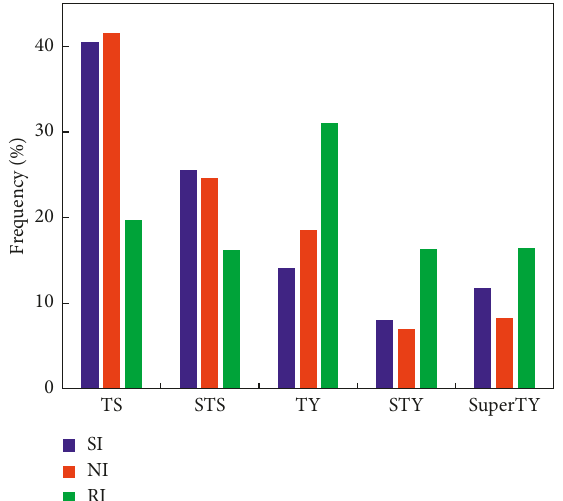
Figure 3: The frequency distribution of the initial intensity of the development in the three intensification categories (RI, NI, and SI) for the period 1995–2015. The definition of TC intensities cate- gories is the same as in Figure 2.